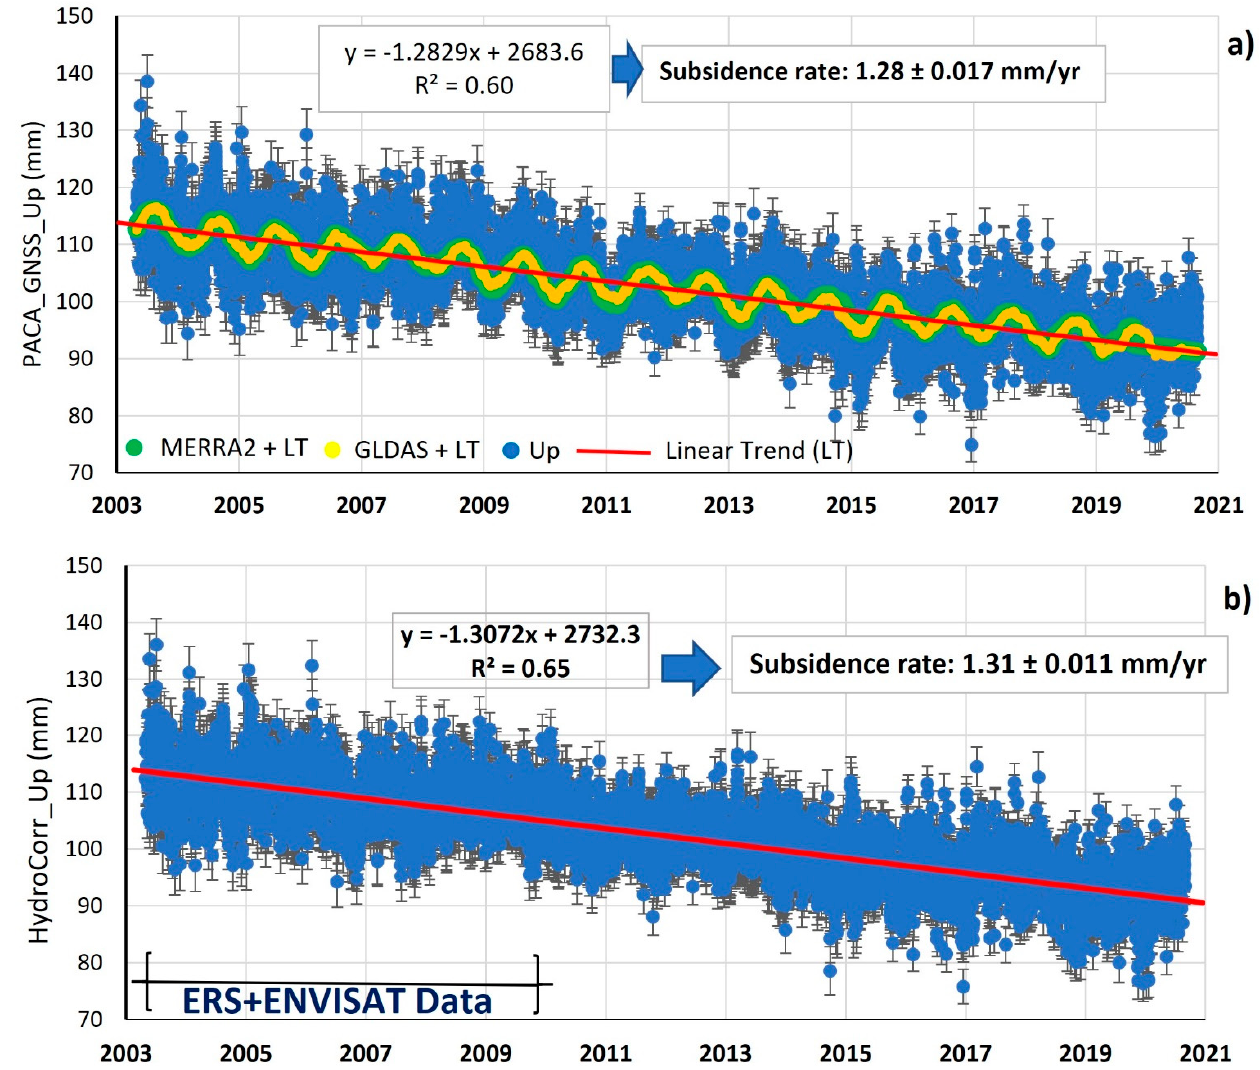
Figure 9. GNSS daily solutions collected at PACA permanent station located in Palma Campania for the up component. Linear trend, which quantifies the subsidence rate, is plotted (red line). A tentative modelling of the hydrological contribution of the observed ground displacement based on MERRA2 and GLDAS models is plotted as well ( a ). GNSS daily solutions, after correction of the hydrological contribution and final assessment of the subsidence rate. The black brackets mark the time range for which the DInSAR dataset is available for comparison ( b ).